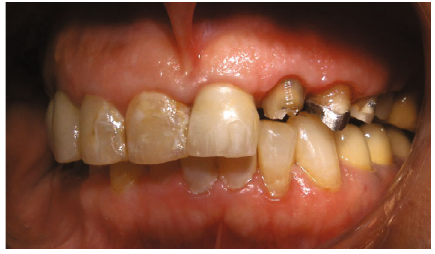
Figure 9: Buccal view of core preparation.